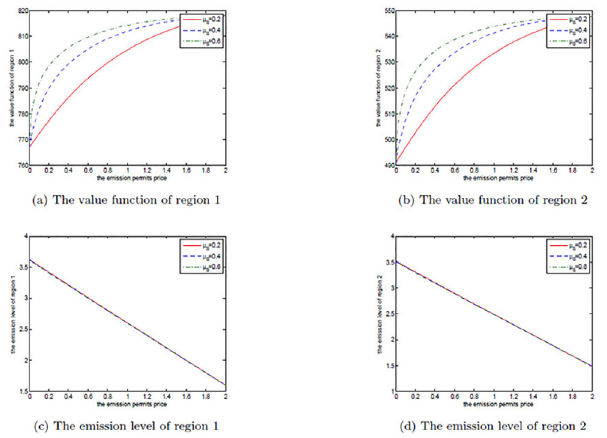
Fig 8. The effects of μ S on the noncooperative